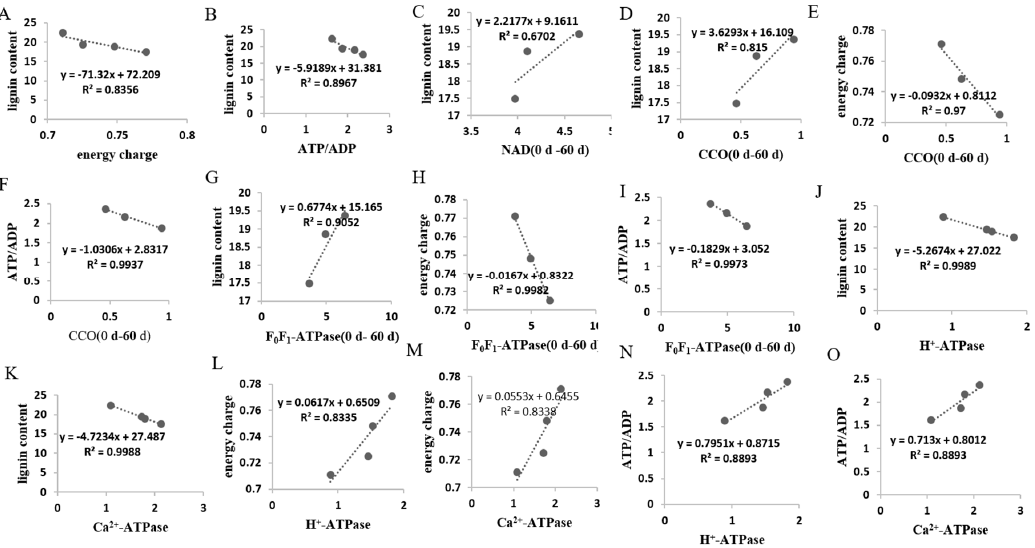
Figure 6. Correlationship between energy charge ( A ), ATP / ADP ( B ), NAD (0–60 d) ( C ), and CCO (0–60 d) ( D ) with lignin; between CCO (0–60 d) ( D ) with energy charge ( E ), and ATP / ADP ( F ); between F 0 F 1 -ATPase(0–60 d) with lignin ( G ), energy charge ( H ), and ATP / ADP ( I ); between H + -ATPase ( J ) and Ca 2 + -ATPase ( K ) with lignin; between H + -ATPase ( L ) and Ca 2 + -ATPase ( M ) with energy charge; and between H + -ATPase ( N ) and Ca 2 + -ATPase ( O ) with ATP / ADP, in juice sacs of “Hongroumiyou” (HR) pumelo fruit.